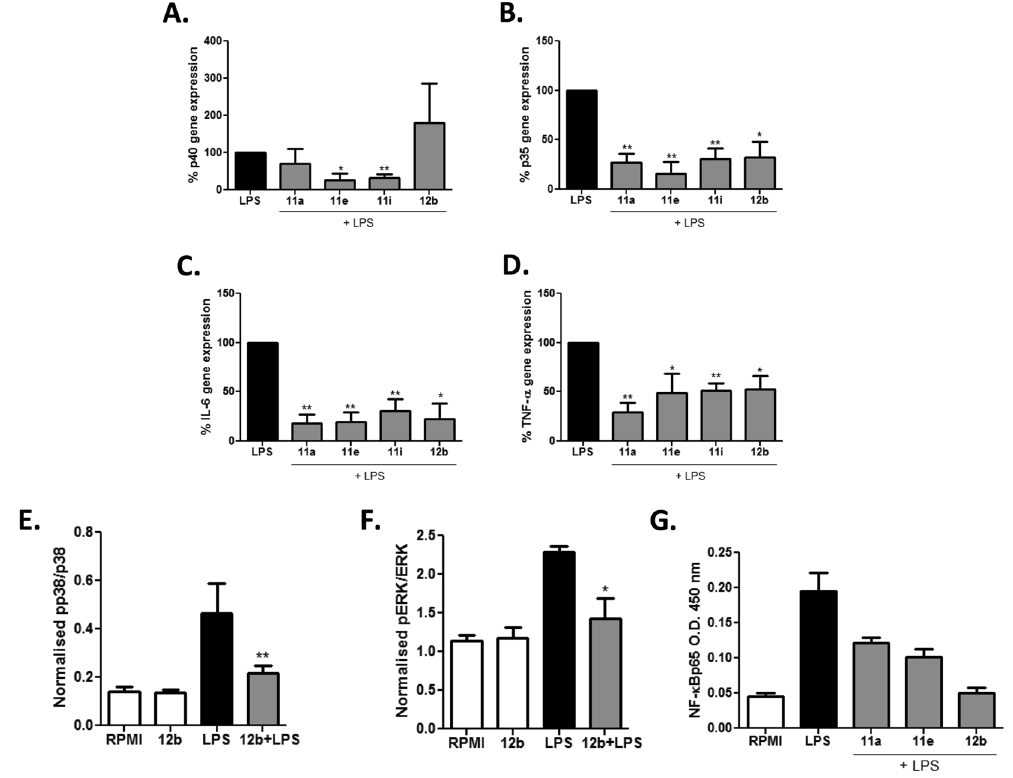
Figure 2. ES-62 SMAs target cytokine production at the level of transcription and display differing effects on the activation of MAPKs and NF- κ Bp65. BmDCs were treated with SMAs 11a, 11e, 11i or 12b (5 μ g/ml) for 18 hours, matured with LPS for 4 h, before extracting RNA and analysing the expression levels of IL-12p40 ( A ), IL-12p35 ( B ), IL-6 ( C ) and TNF- α ( D ) by qRT-PCR. Cytokine expression was normalised to GAPDH and the levels of mRNA in SMA + LPS (from all experiments [n = 3]) compared to LPS (100%) DC calculated and compared using a one sample t test. Results are expressed as the mean ± SEM. BmDCs were treated with SMA 12b for 18 hours and then stimulated with LPS for 10 minutes and the levels of total and phosphorylated p38 ( E ) and ERK ( F ) measured by fast-activated cell ELISA (FACE). Phosphorylated p38 or ERK1/2 absorbance were normalised to the corresponding total p38 or ERK1/2 absorbance and the data expressed as means (of triplicate determinations) ± SD. Data were analysed using one way ANOVA with Bonferroni post-test where for statistical analysis, * p < 0.05; ** p < 0.01. As above, bmDCs were incubated with SMAs for 18 hours before stimulation with LPS for 30 minutes and the level of p65 activation in duplicate samples measured by TransAM ( G ). All data are representative of at least two independent